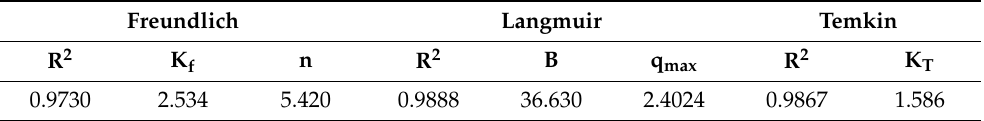
Table 4. Value of R 2 and different constants for the Freundlich, Langmuir, and Temkin isotherm models for the adsorption of different concentrations of Cr(VI) by